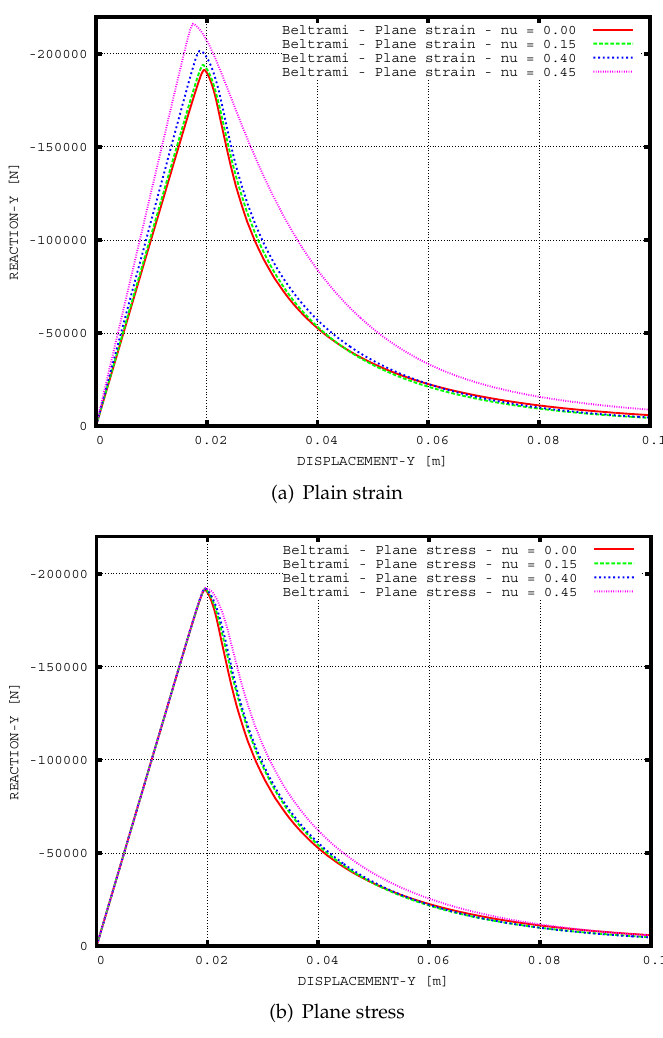
Figure 9. Uniaxial tension of a perforated strip: load versus displacement curves for the Simó and Ju [41]